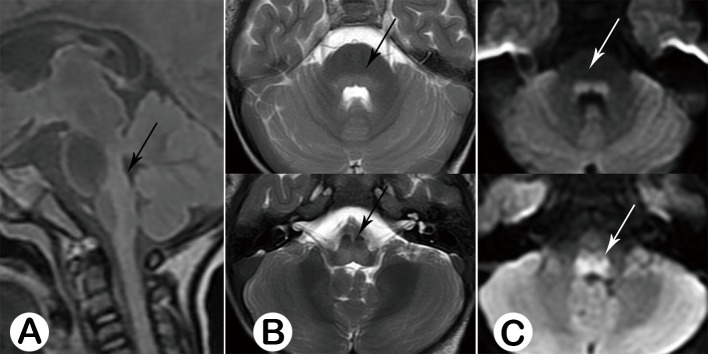
Postmortem stage, Male, 37 months old, on the 2nd day of the disease.Sagittal FALIR (A, black arrow) and axial T2WI (B, black arrow) showed the whole posterior portion of the brainstem was involved, demonstrating hyper-intensive signal, with restricted diffusion (C, black arrow).